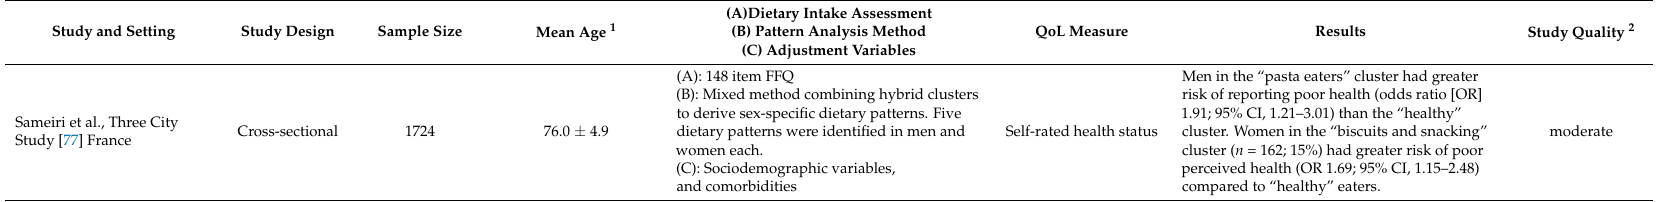
Men in the “pasta eaters” cluster had greater risk of reporting poor health (odds ratio [OR] 1.91; 95% CI, 1.21–3.01) than the “healthy” Self-rated health status cluster. Women in the “biscuits and snacking” cluster ( n = 162; 15%) had greater risk of poor perceived health (OR 1.69; 95% CI, 1.15–2.48) compared to “healthy”